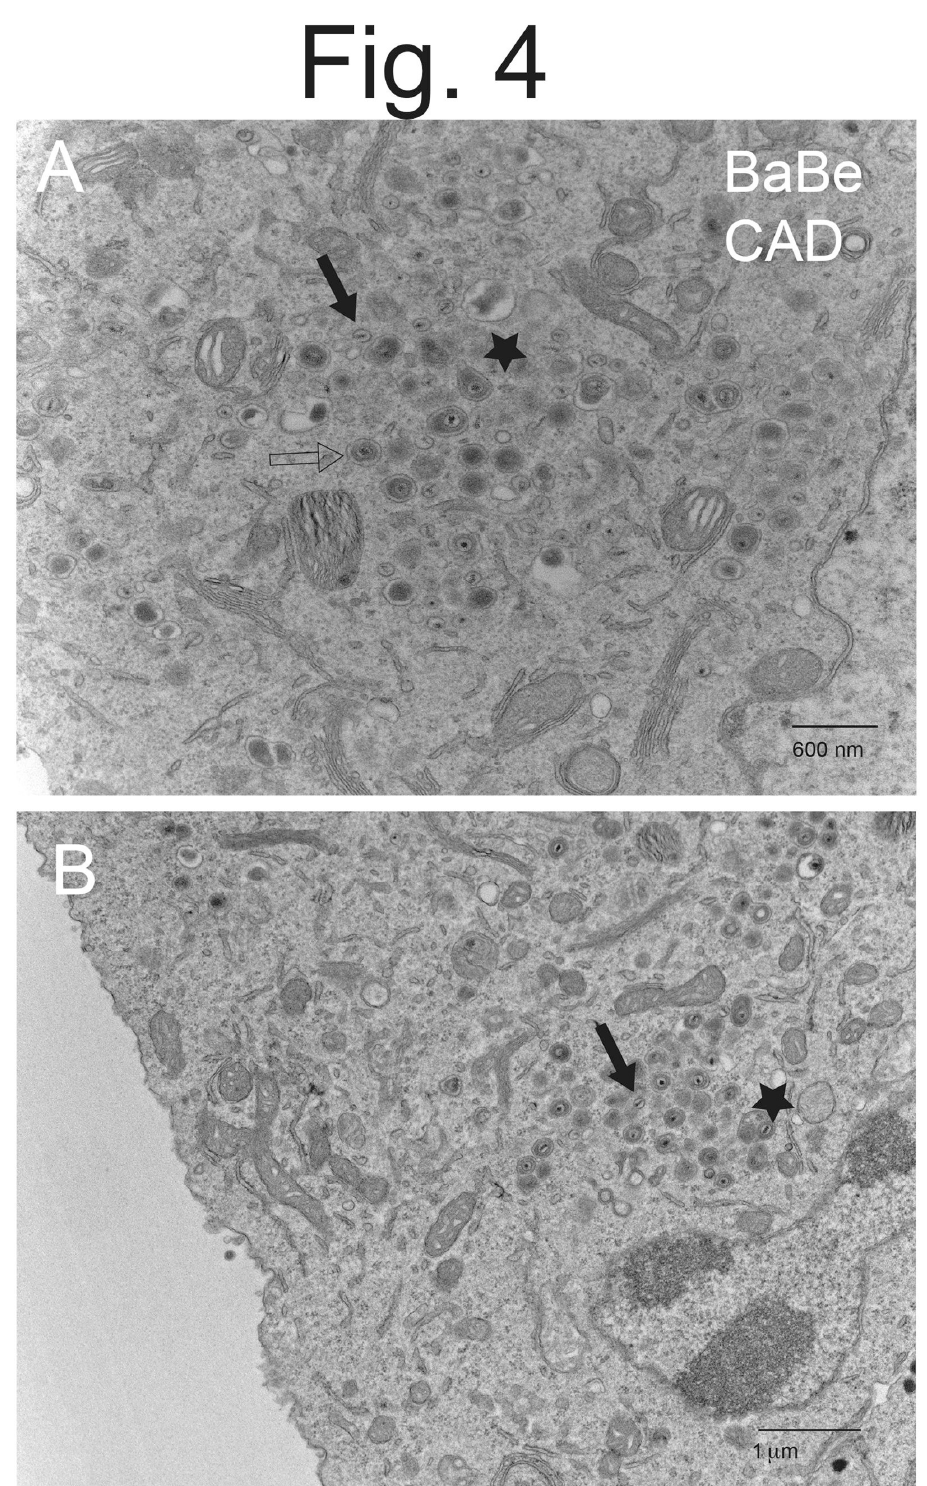
Figure 4. Higher magnification EM of CAD neurons infected with PRV BaBe. CAD neurons were infected with BaBe as in Figure 3 and processed for EM. Panel ( A ) shows fully enveloped virus particles in cytoplasmic vesicles (empty arrow), unenveloped capsids (solid arrow) and misassembled enveloped particles with oblong shapes and electron-dense material associated with the capsids (star). Panel ( B ) shows unenveloped capsids (solid arrow) and cytosolic vesicles with several virus particles